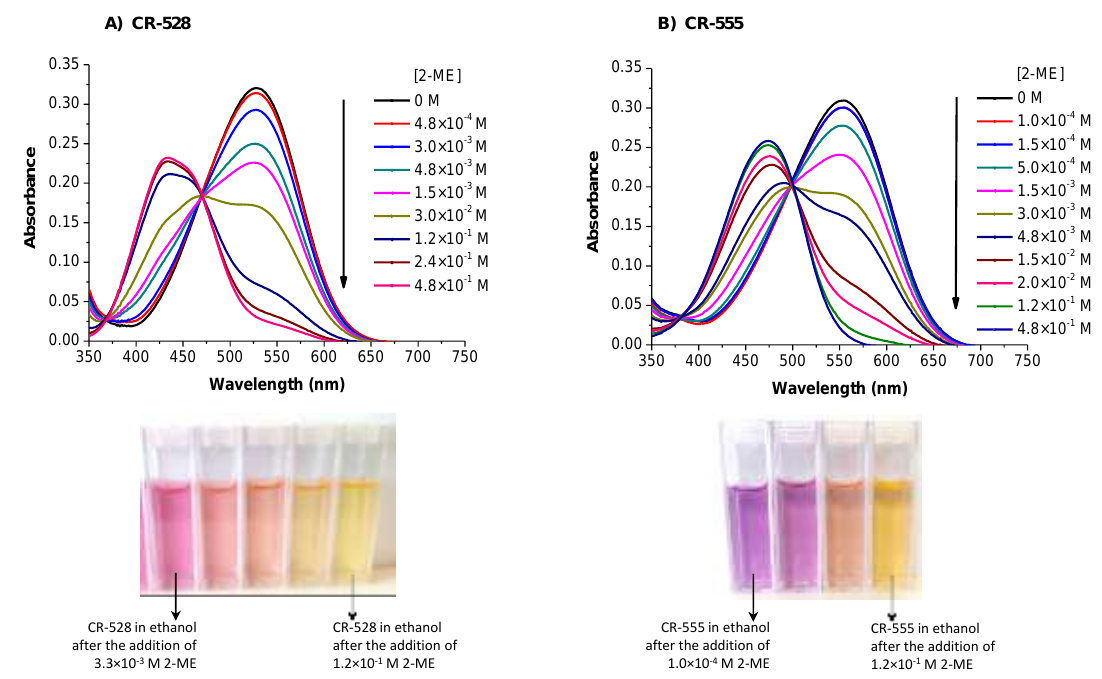
Figure 3. Absorption spectra of CR-528 (2.4 × 10 −7 M; ( A )) and CR-555 (2.6 × 10 −7 M; ( B )) in the presence of various concentrations of 2-ME (from 0 to 4.8 × 10 −1 M) in ethanol solution.